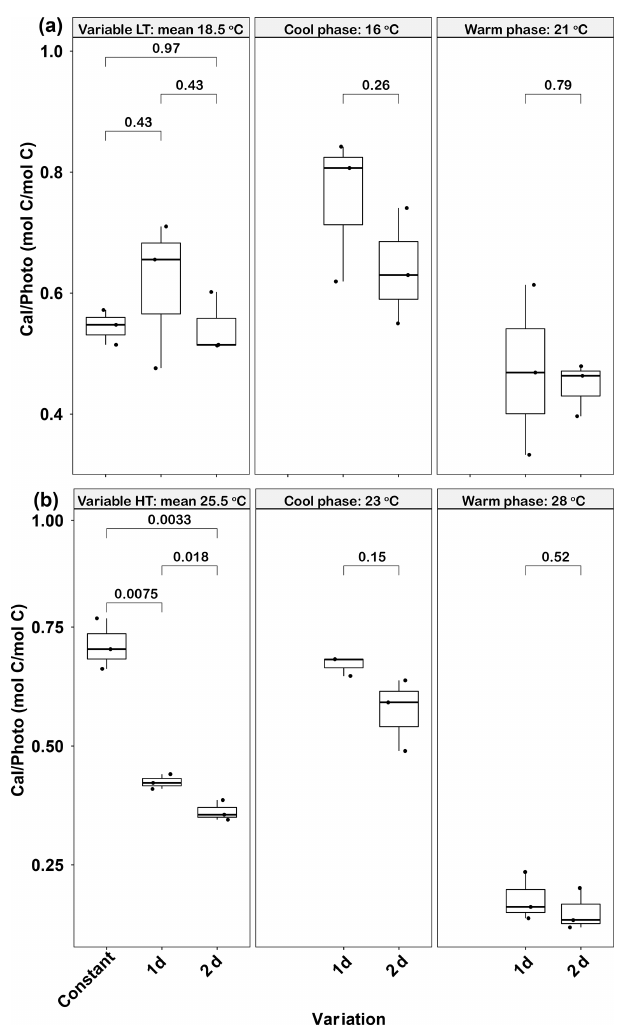
Figure 6. Responses of Emiliania huxleyi calcification to photo- synthesis ratios (Cal / Photo) to constant temperatures and during the warm and cool phases of two thermal variation frequencies (1 and 2d) under low (a) and high (b) mean temperatures. LT: low temperature; HT: high temperature. The thick black line in the box- plots represents median values for each experimental treatment; the whiskers on the boxplots indicate 1.5 × interquartile range. Listed p values with their respective brackets denote the statistical signifi- cance between two